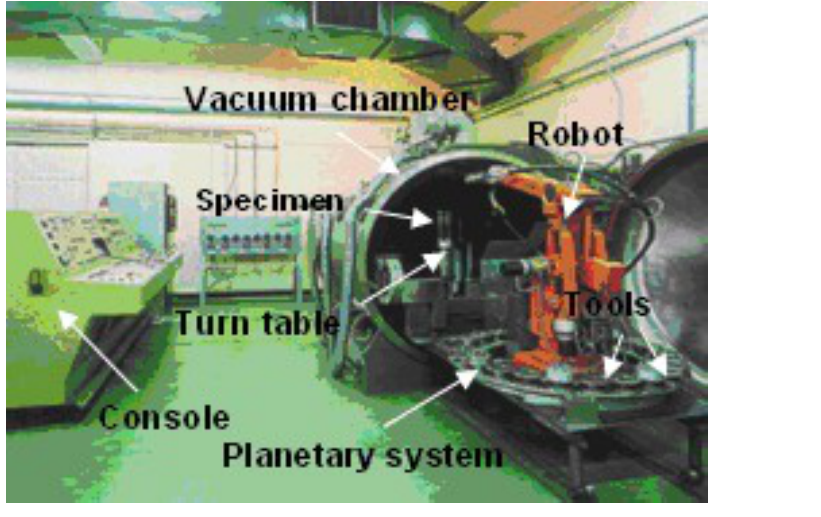
Figure 2 – Vacuum plasma spray